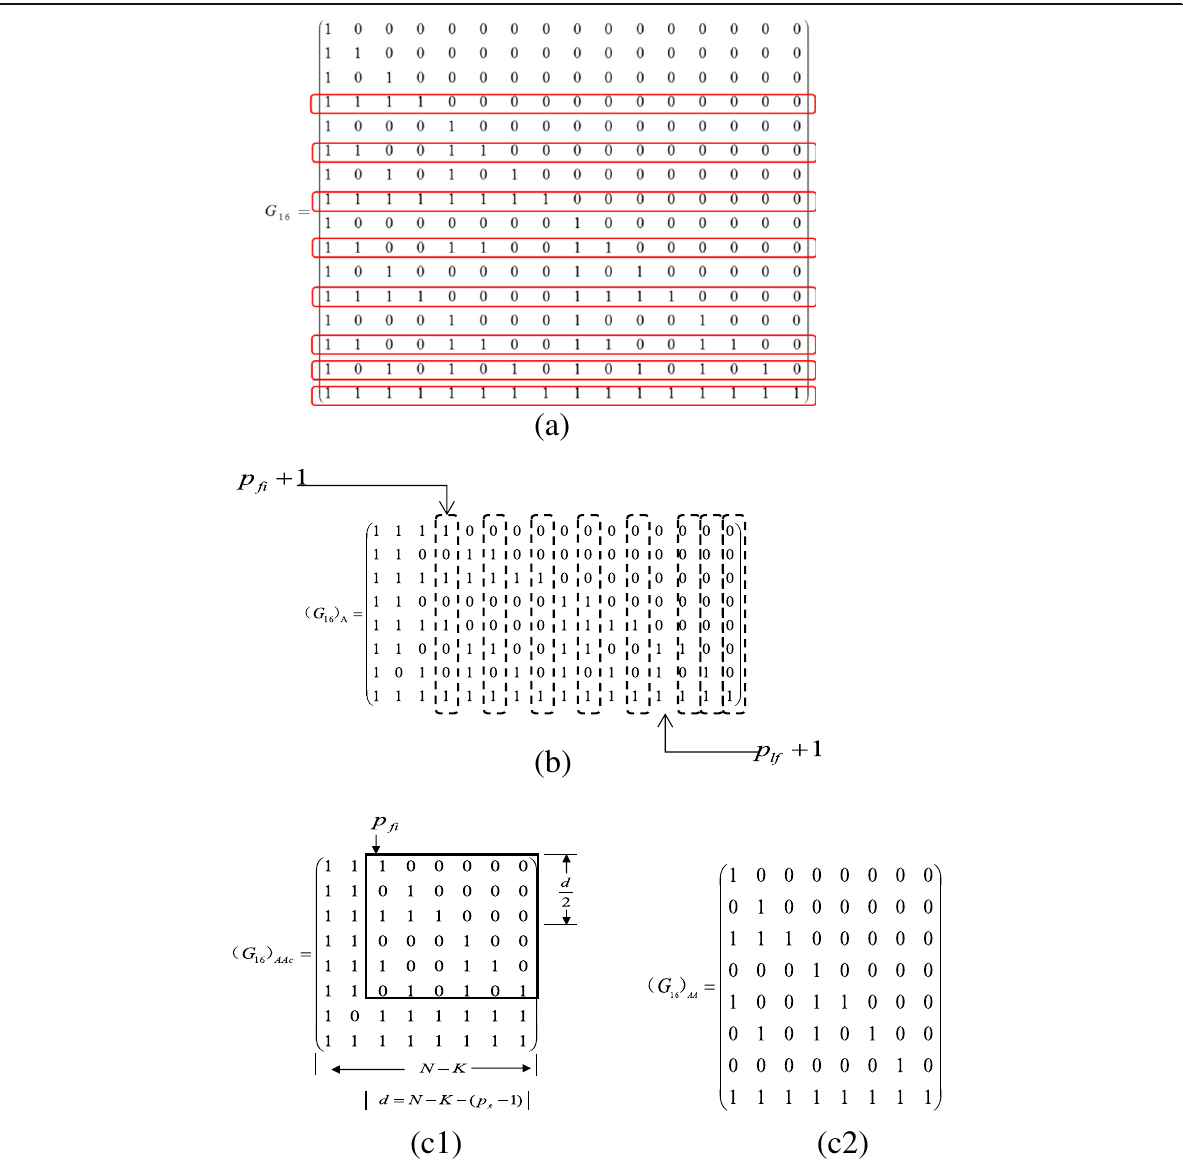
Fig. 8 Matrix extraction process: For the generator matrix of G 16 in a, the rows of information bits indices can be extracted to form ( G 16 ) A shown in b . a – c 2 illustrate the detailed process of matrix transformation. The row elements in the solid line box in a are formed into a new matrix ( G 16 ) A shown in